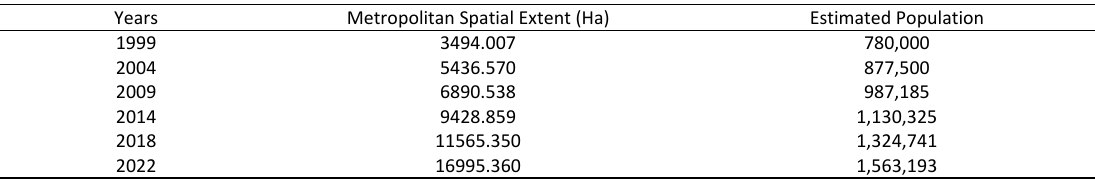
Table 6: The Metropolitan Land Consumption and Population statistics.